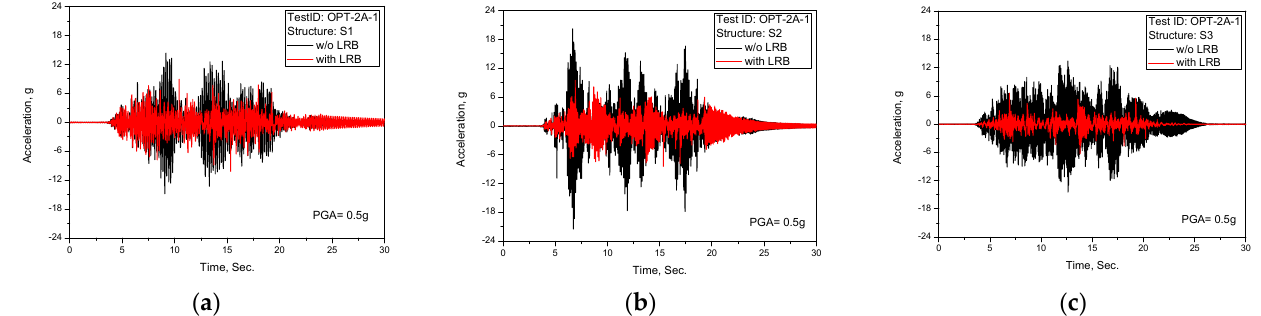
Figure 6. Test results of acceleration time history response (TEST ID: OPT-2A-1, PGA = 0.5 g): ( a ) S1; ( b ) S2; ( c ) S3.